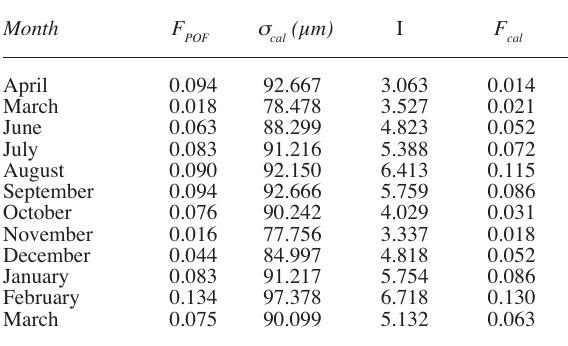
T ABLE 2. – Monthly spawning fractions from the histological method of postovulatory follicles ( F tions of the oocyte diameter distribution in the more advanced batch (